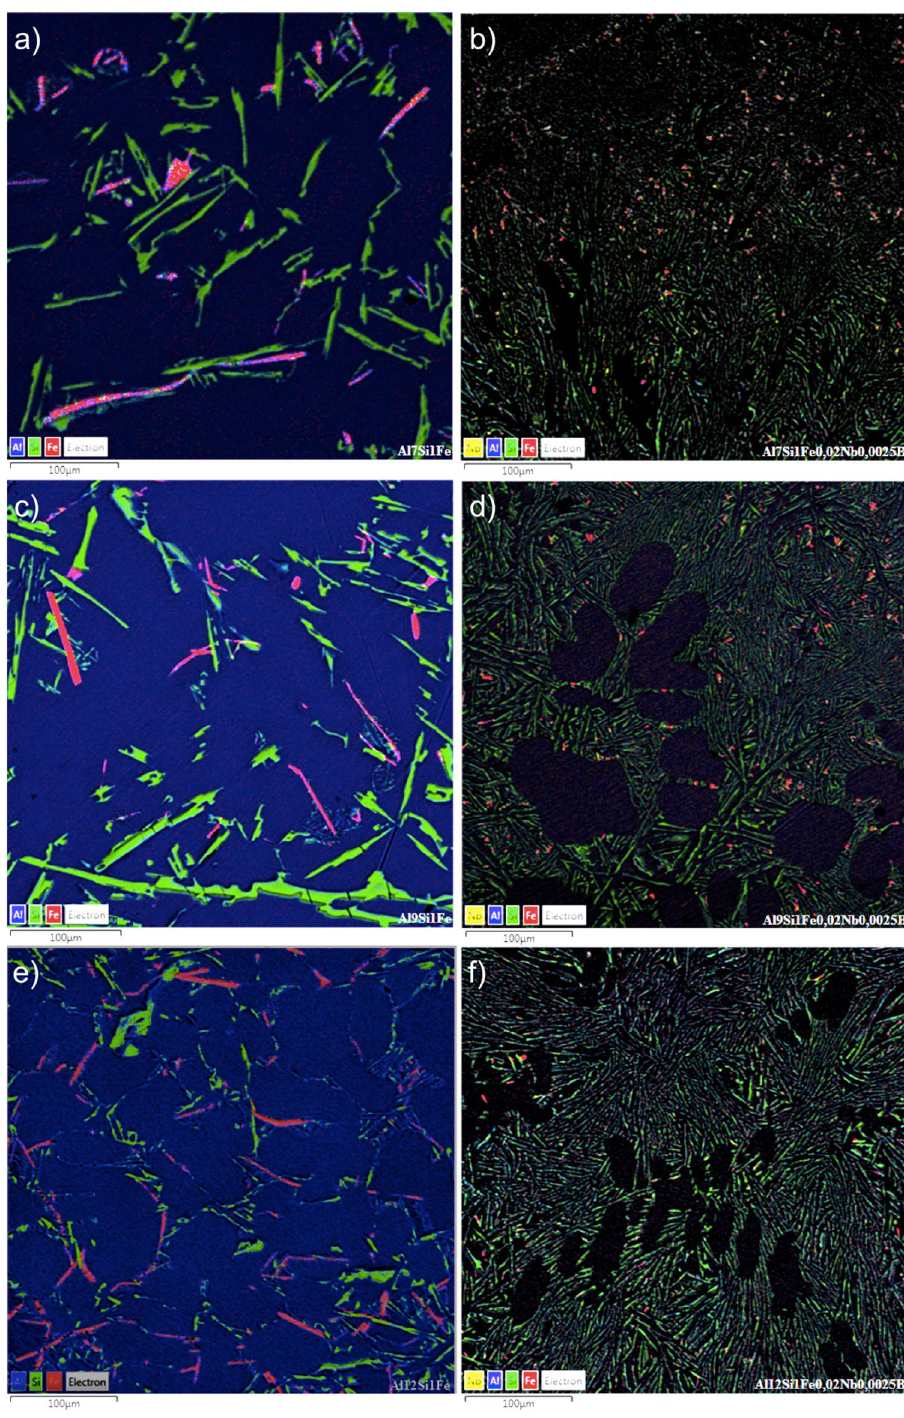
Figure 8. SEM–EDS images displaying the microstructure of the alloys containing 7 ( a , and b ), 9 ( c , and d ) and 12 wt% Si ( e , and f ) and 1 wt% Fe, without Nb addition ( a , c , and e ) and with 0.02 wt% Nb ( b , d , and f ). Al, Si and Fe are highlighted in blue, green and red,